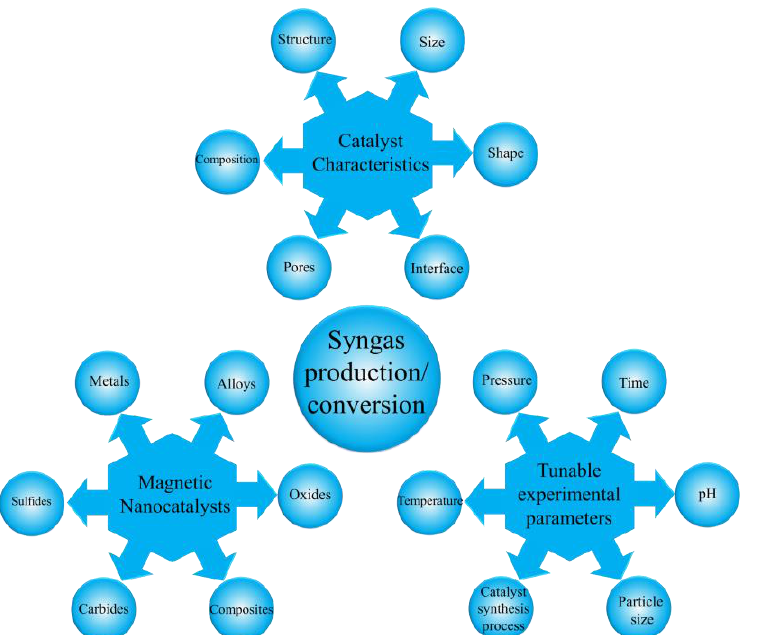
Figure 19. Schematic diagram for the typical characteristics of magnetic nanomaterials, types of magnetic nanomaterials, and experimental parameters that can be tuned to improve the performance of catalysts for syngas production/conversion.